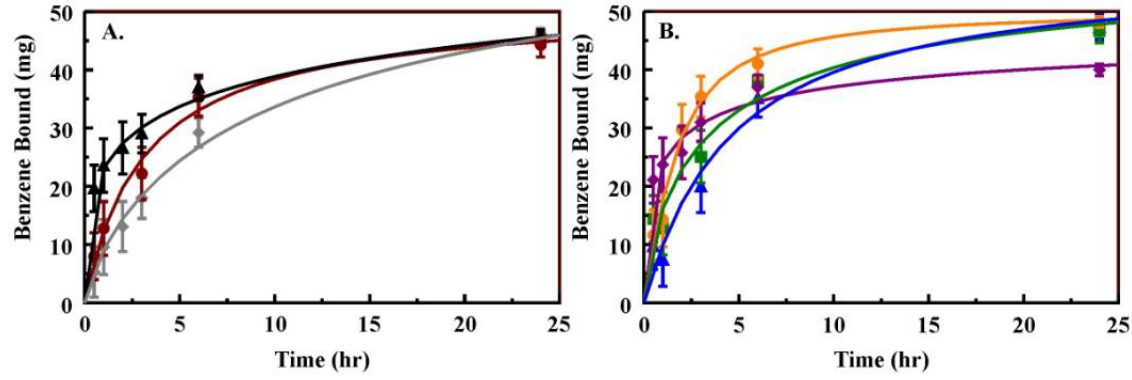
Figure 4. Binding kinetics from vapor phase. Shown here are the kinetics of benzene binding for each of the organosilicate materials. Benzene (53 mg) was allowed to diffuse within a volume of 125 mL for the indicated time (20 °C). Panel A, B100 (black), OTS (red), and BP2 (gray). Panel B, DEB (orange), Ph1 (green), PhE1 (blue), and TM1